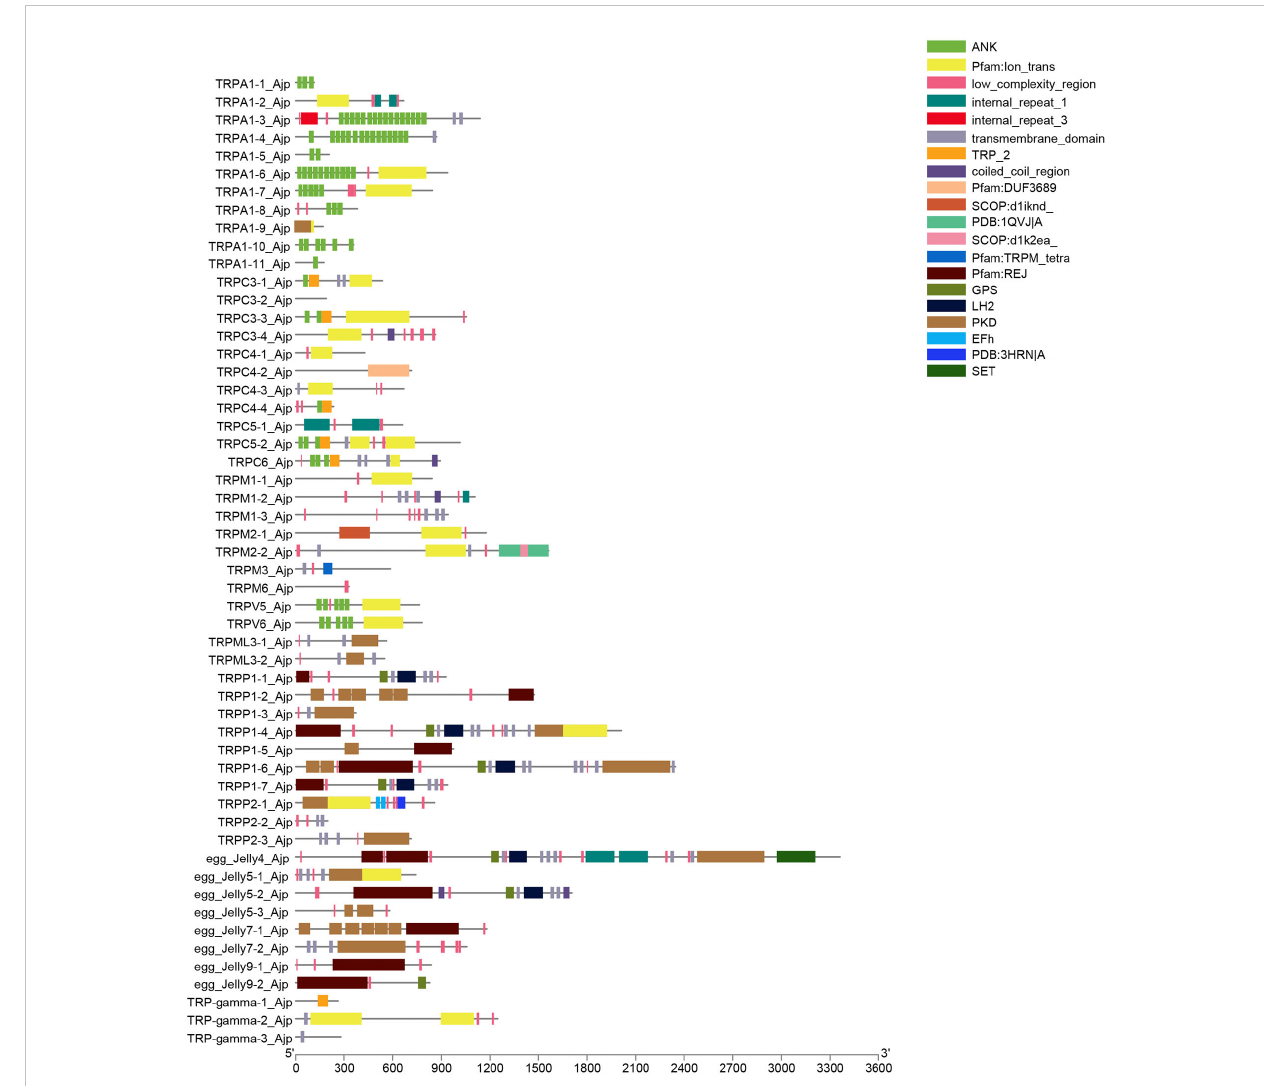
FIGURE 3 The conserved domains of the TRP proteins. Domains that have been identi fi ed are represented in color; the lines indicate that the domain is not